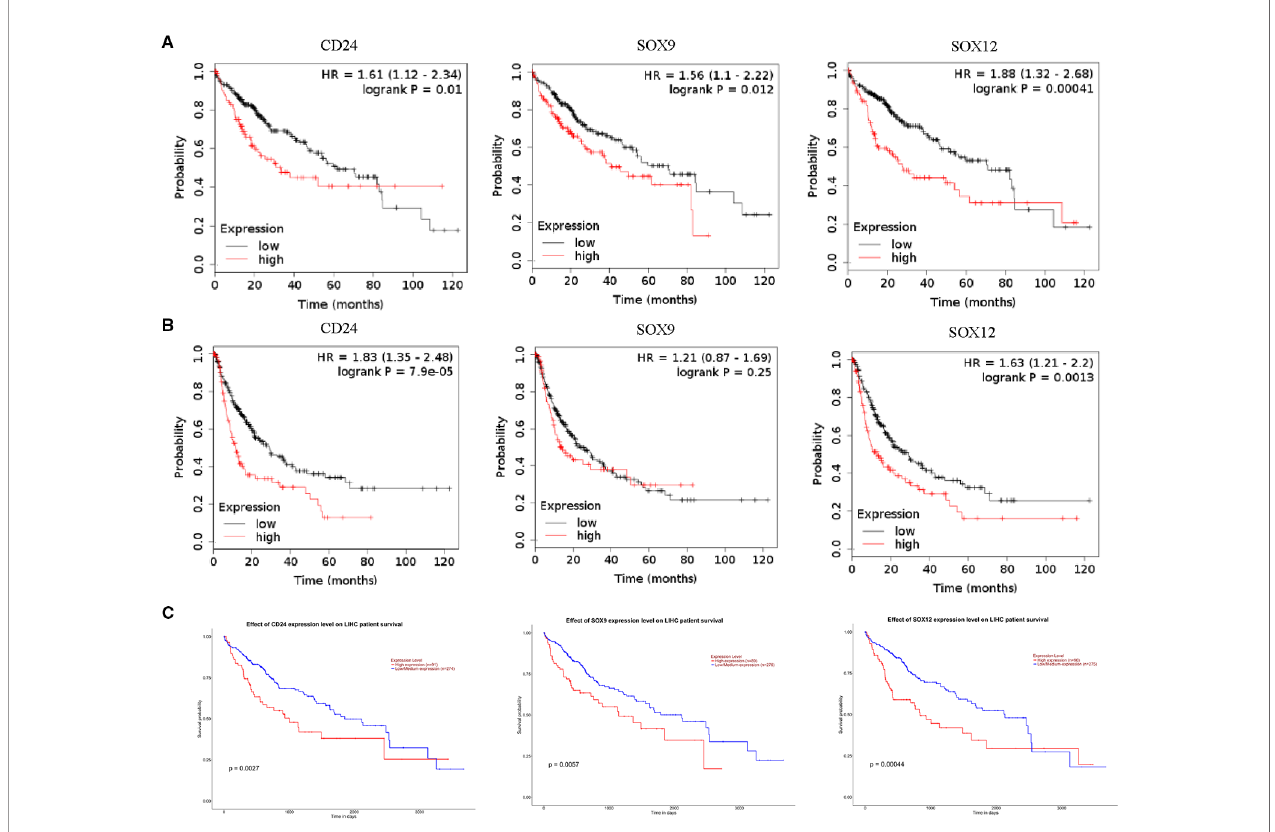
FIGURE 2 | Association of HCSC markers expression levels and prognosis of HCC. (A) Correlation of HCSC markers high expression levels with OS of HCC, n = 364, (B) correlation of HCSC markers high expression levels with PFS of HCC, n = 370, red font means negative correlation, green font means positive